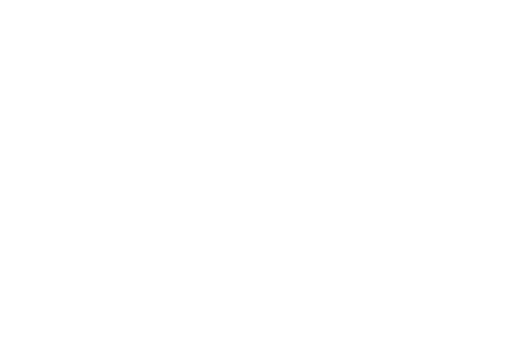
Table 3. The Calibration of Voltage and Current